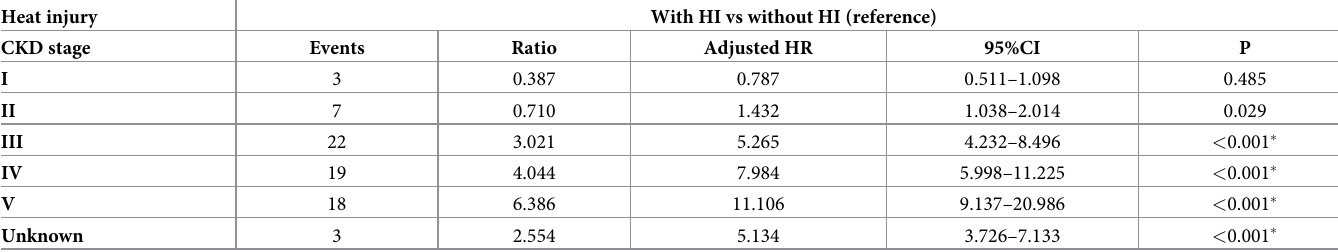
Abbreviations: Adjusted HR = Adjusted Hazard ratio: Adjusted for the variables listed in Table 2.; CI: Confidence interval; CKD: Chronic kidney disease; HD: